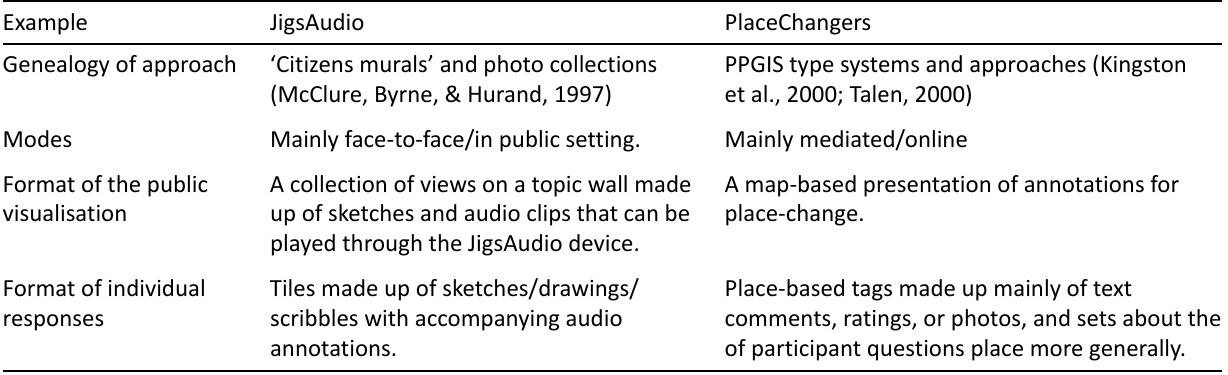
Table 1. Overview of JigsAudio and